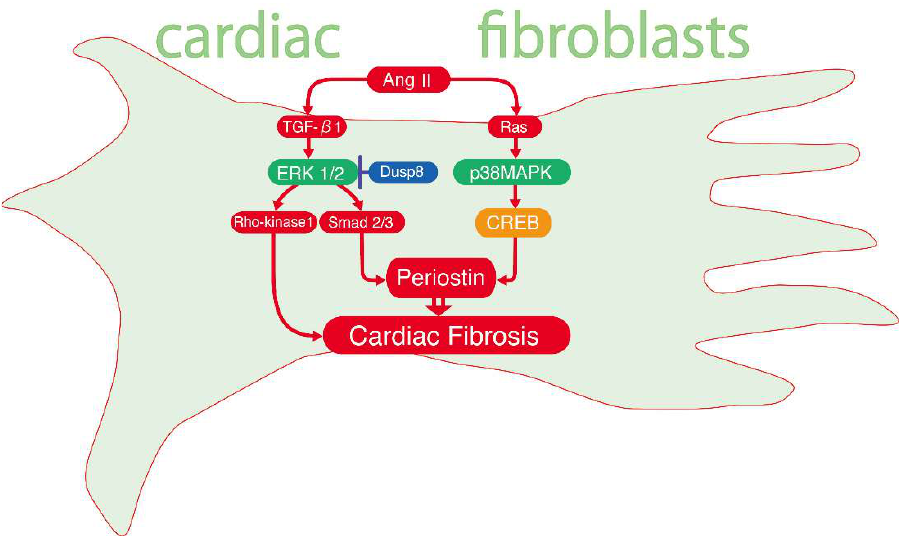
Figure 1. Ang-II induced cardiac fibrosis mediated by periostin. Ang II activates TGF-β1 and Ras, thus inducing ERK1/2 and p38 MAPK phosphorylation, respectively. ERK1/2 stimulates Smad2/3,